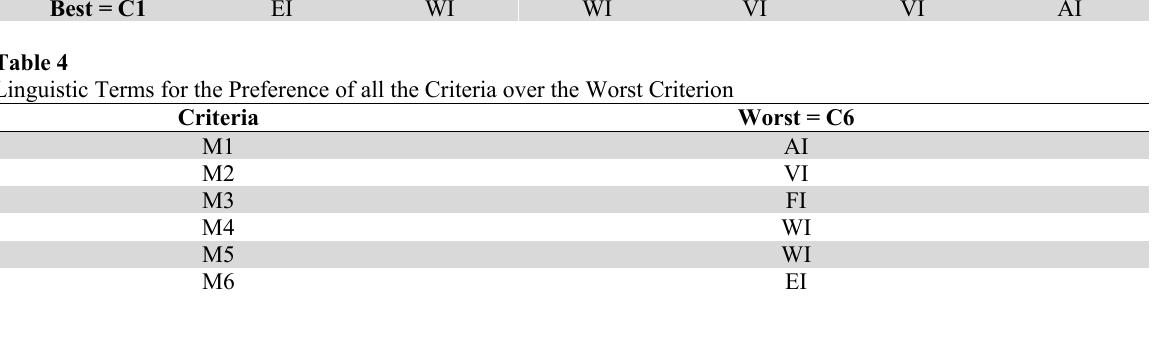
Linguistic Terms for the Preference of the Best Criterion over all the Criteria Criteria